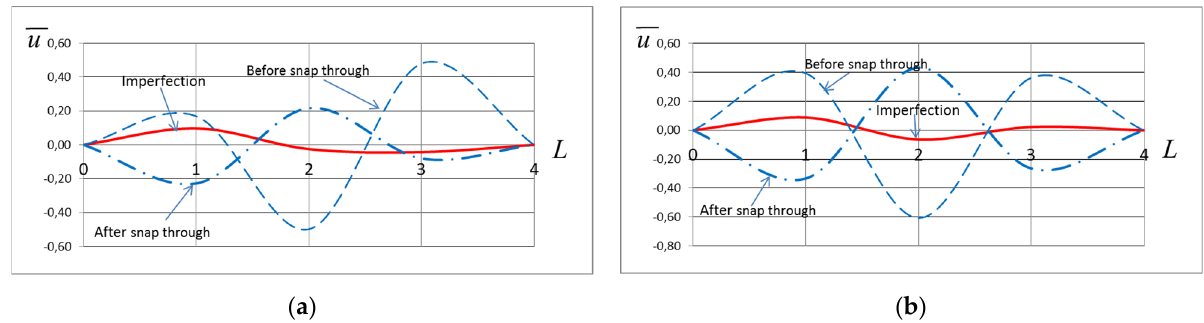
Figure 22. Configuration of displacement before and after snap-through for initial amplitudes of geometrical imperfections developed according to the first and second or third buckling mode; ( a ) m 1 d 2 s 3, ( b ) m 1 s 2 d 3.